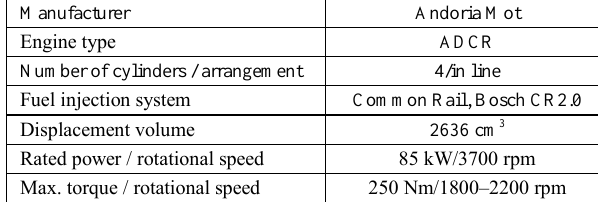
Table 2. Technical data of the engine